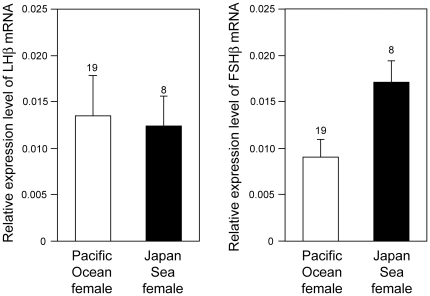
Relative expression levels of mRNA in the pituitary glands for LHβ and FSHβ, determined by qPCR.The sample size is shown above each column.